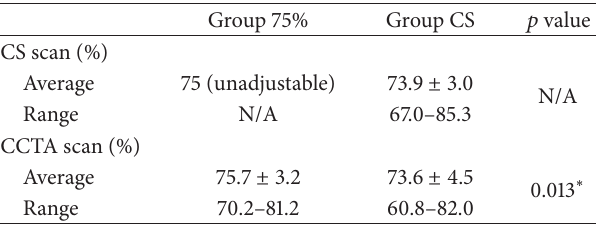
Table 3: Comparison of reconstruction phases between both reconstruction methods.